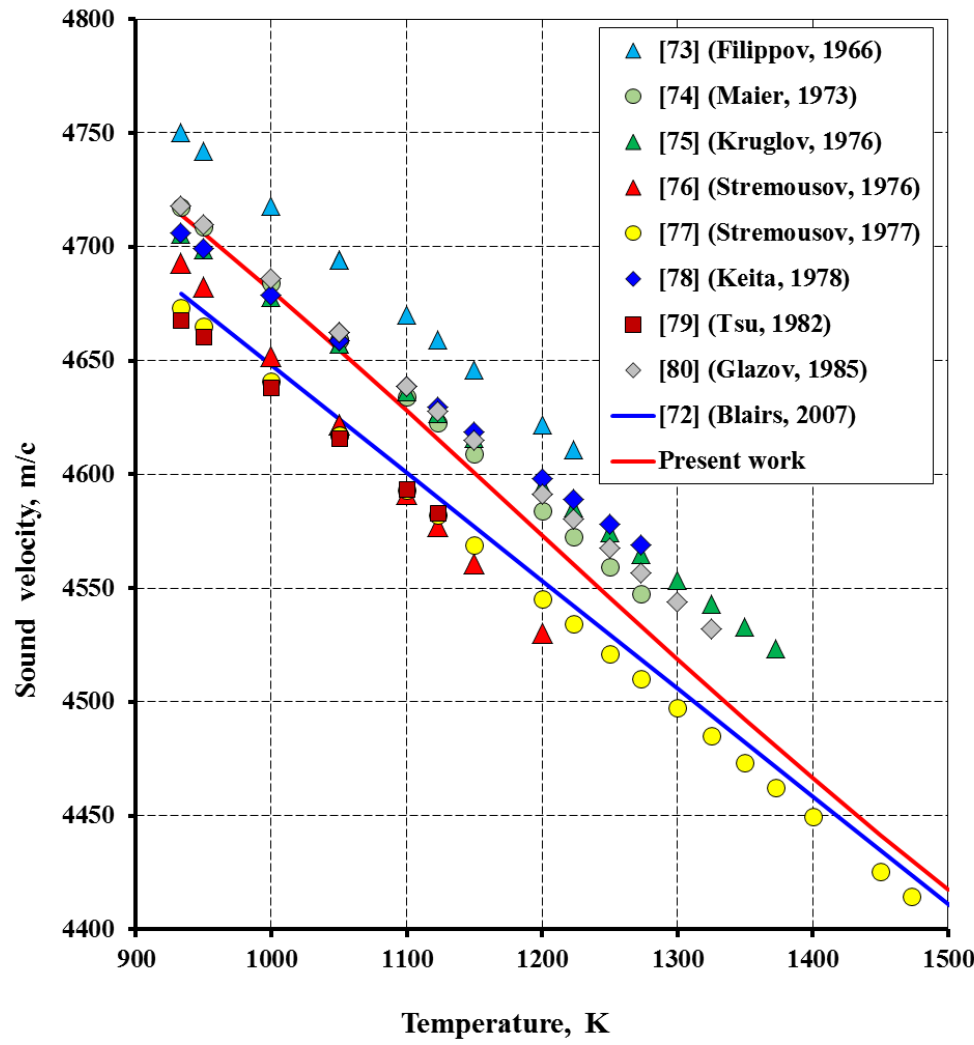
Figure 7. Sound velocity in liquid aluminum.